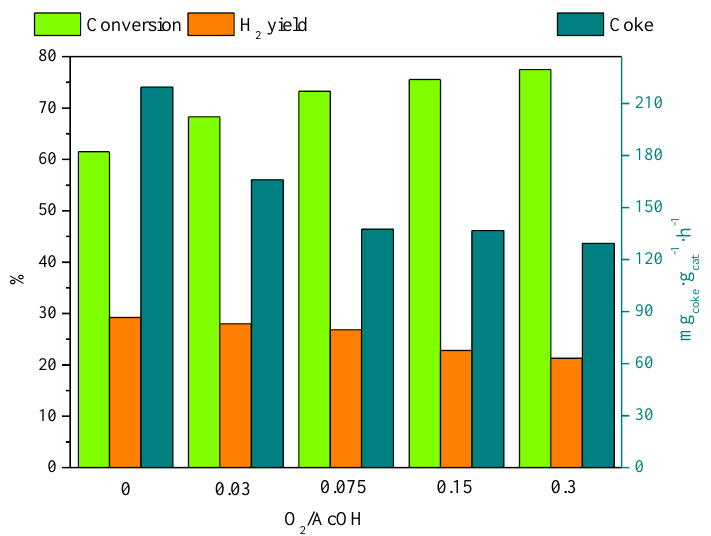
Figure 6. Catalytic results in terms of conversion, hydrogen yield, and coke deposition for different O 2 /AcOH molar ratios (0 – 0.3) at 500 °C after 5 h TOS for Ni/CeO 2 . Ni/CeO 2 -SBA-15 and Ni/CeO 2 -m reached almost complete conversion at short TOS, but the Ni/CeO 2 -SBA-15 sample decreased conversion values when TOS is above 3 h.